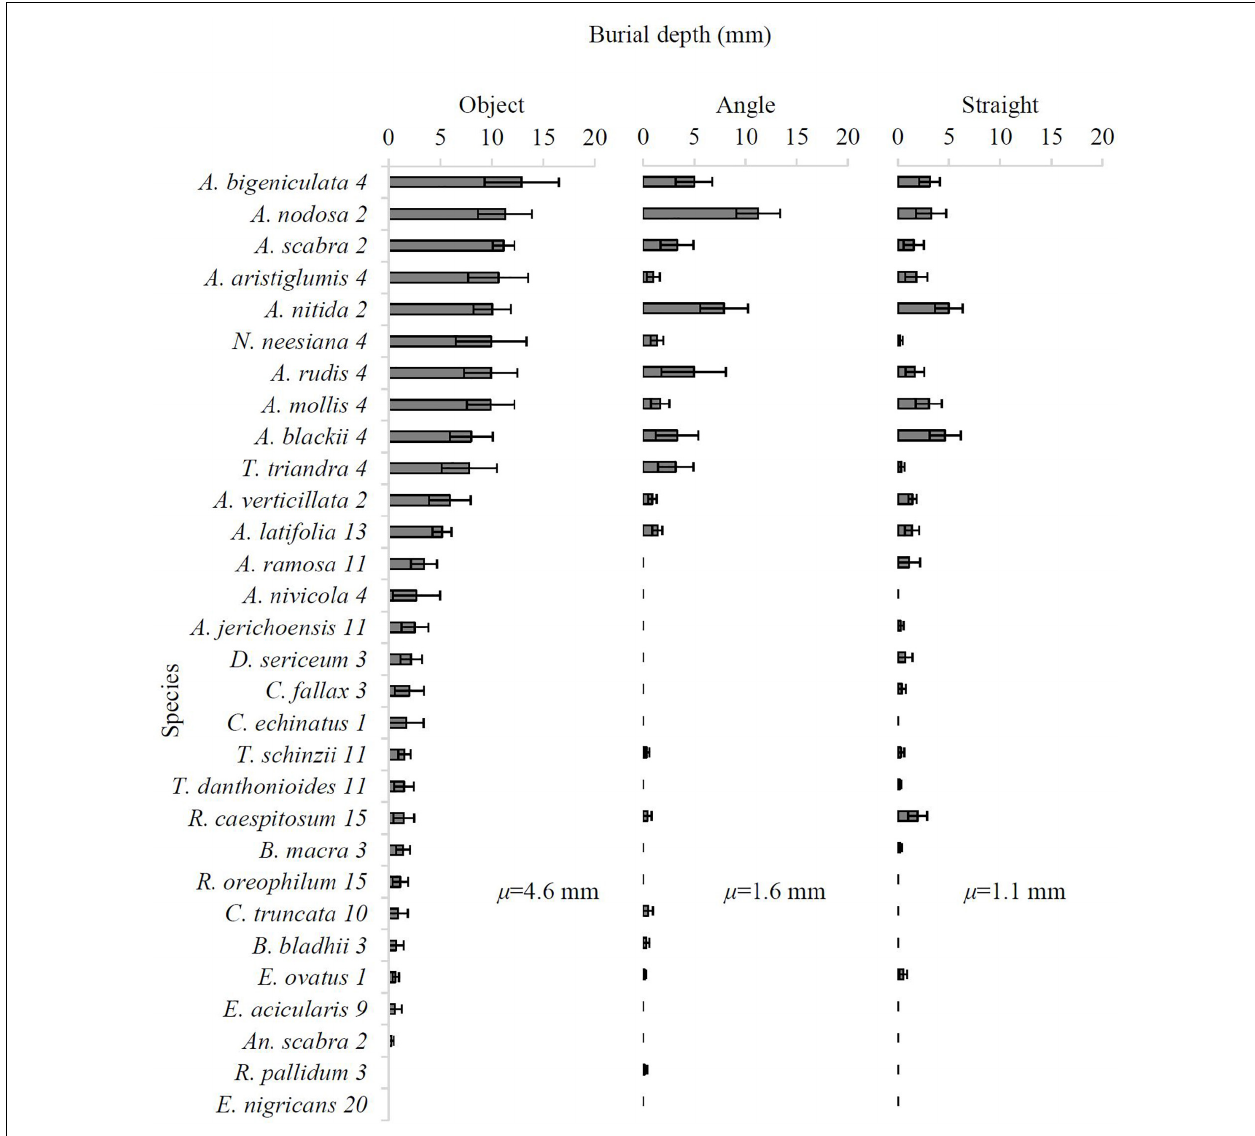
FIGURE 4 | Mean burial depth (BD A ) (in mm) of diaspores for all 30 species across the Object, Angle, and Straight treatment classes (six replicates per species per treatment) after 21 days. Error bars represent one standard error. Species name is followed by awn type (see Table 1 ). µ = mean BD A (mm) of treatment.